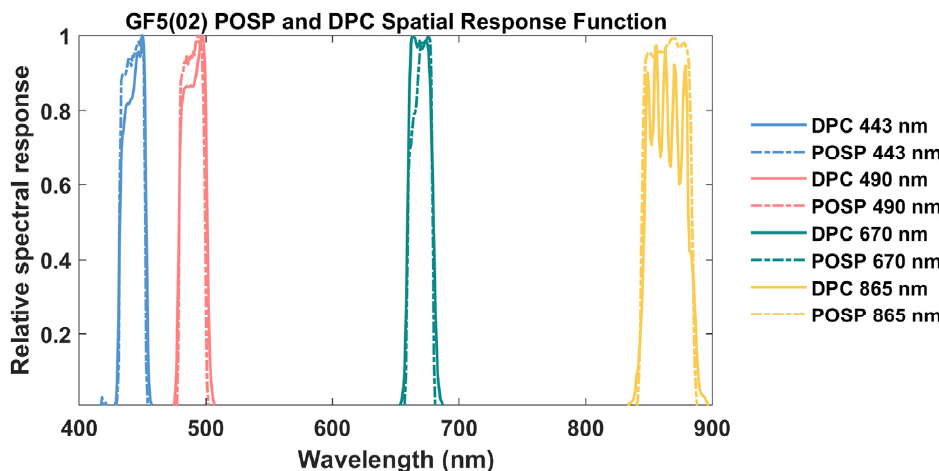
Figure 4. Normalized relative spectral responses of DPC and POSP common bands.